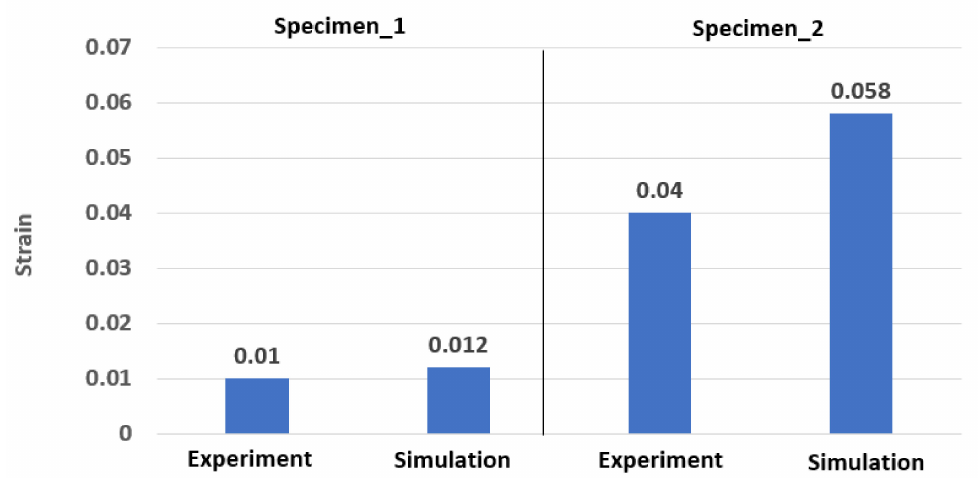
Figure 20. Comparison of the final strains reached in the simulation and experiment for Specimen_1 and